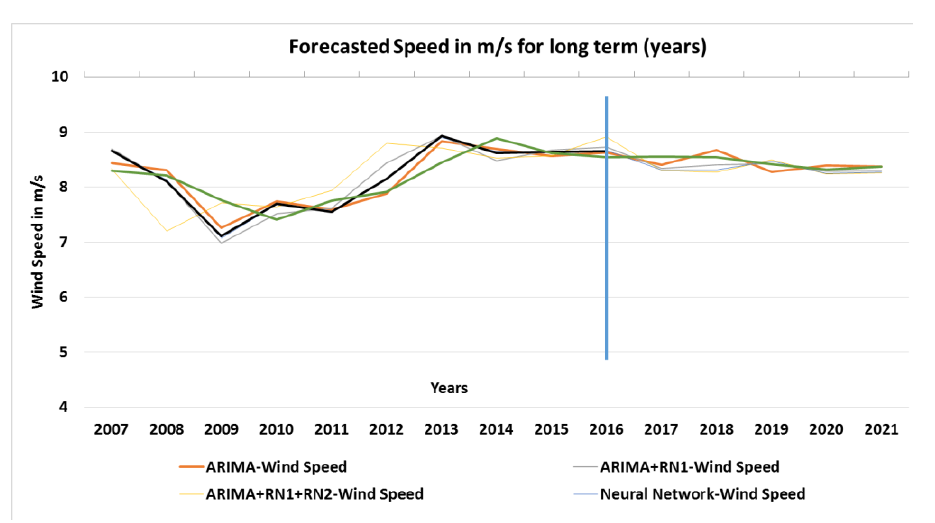
Figure 19. Predicted generated power in kW for long-term forecasting (years). Source: Authors.